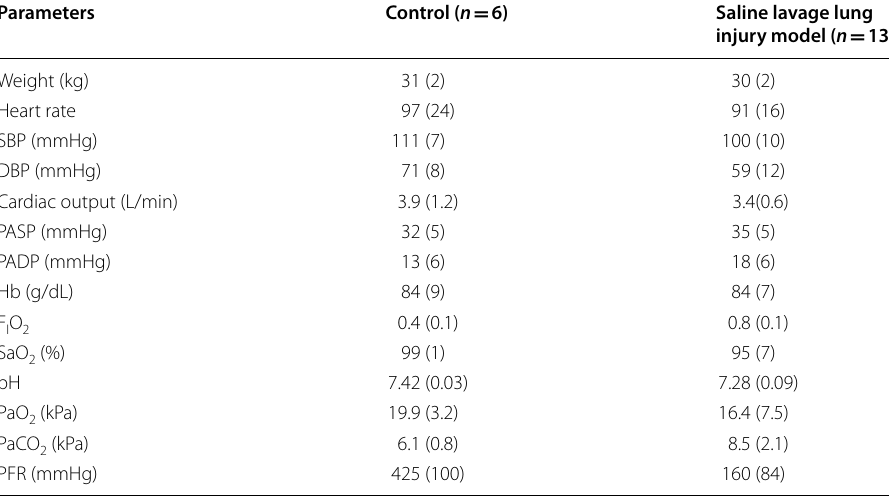
Control animals and saline lavage lung injury model, mean (SD) are shown SBP, systolic blood pressure; DBP, diastolic blood pressure; PASP, pulmonary artery systolic pressure; PADP, pulmonary artery diastolic blood pressure; Hb, haemoglobin; F I O 2 , fraction of inspired O 2 ; SaO 2 , arterial oxygen saturation; PaO 2 , arterial O 2 partial pressure; PaCO 2 , arterial CO 2 partial pressure; PFR, PaO 2 :F I O 2